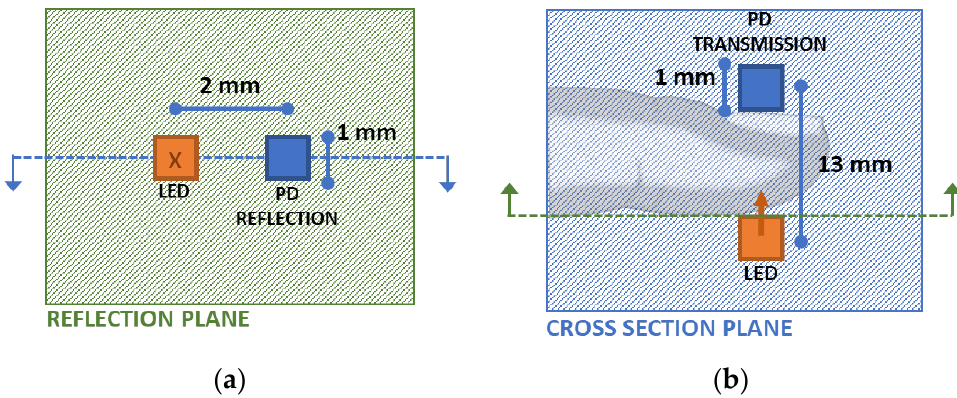
Figure 8. Light-emitting diode (LED) and the photodetector (PD) arrangements for the fingertip model ( a ) on the reflection plane with the blue dotted line and ( b ) on the fingertip cross-sectional plane with the green dotted line indicating the perpendicular planes. The perpendicular planes are indicated with dotted lines and blue-green colors (blue: cross section plane, green: reflection plane).